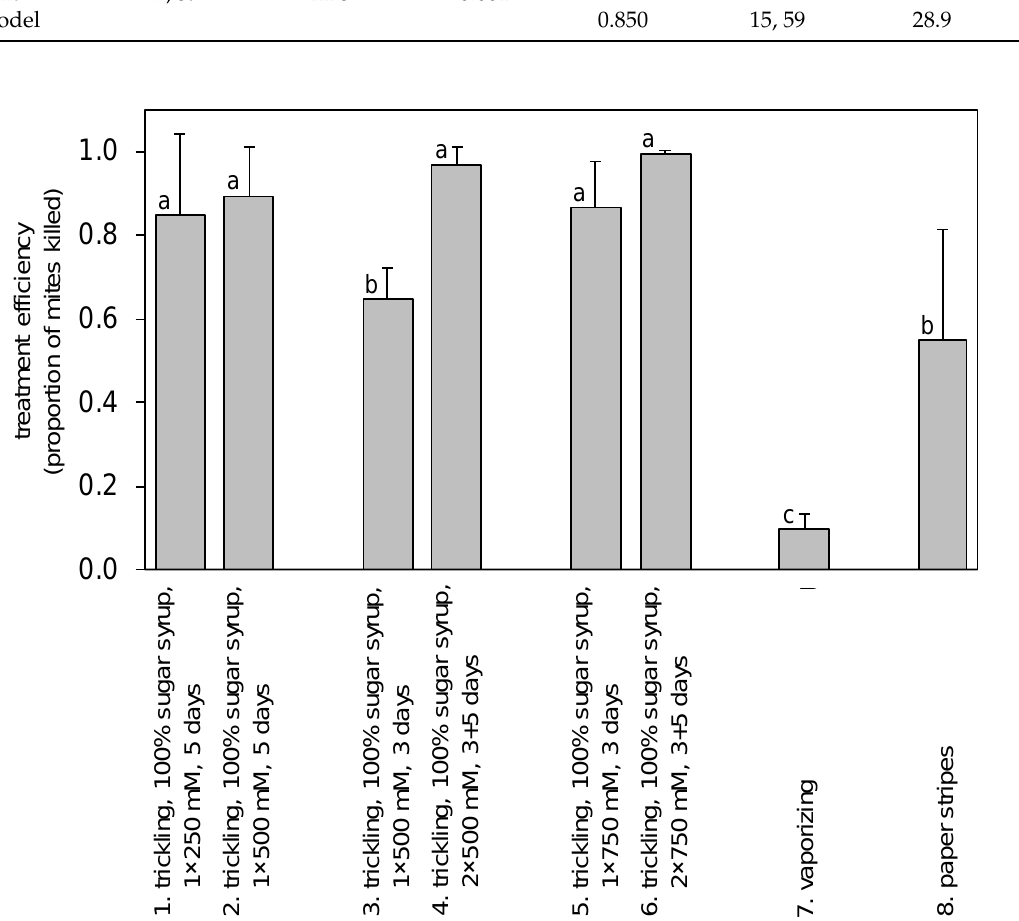
Figure 1. General linear model analysis considering the influence of the number of mites (covariate) on treatment efficiency via the separate-slopes design revealed significant variation in efficiency (mean ± SD) across eight anti- Varroa LiCl treatment types (for statistics, see Table 3). Plotted values marked with different letters are statistically different at p < 0.05 (Tukey HSD post hoc test).